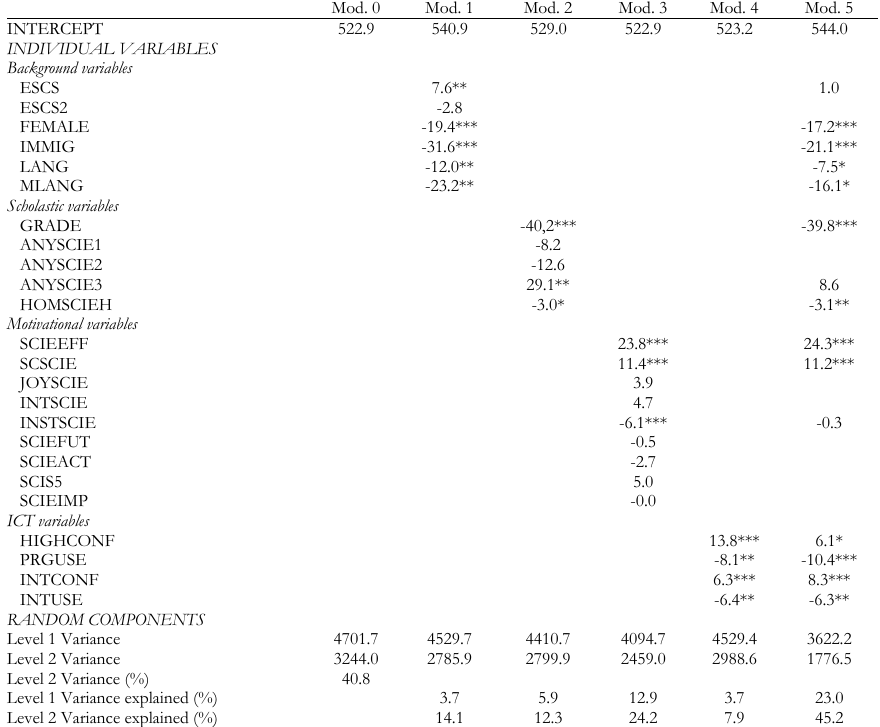
Net effects of level 1variables on science